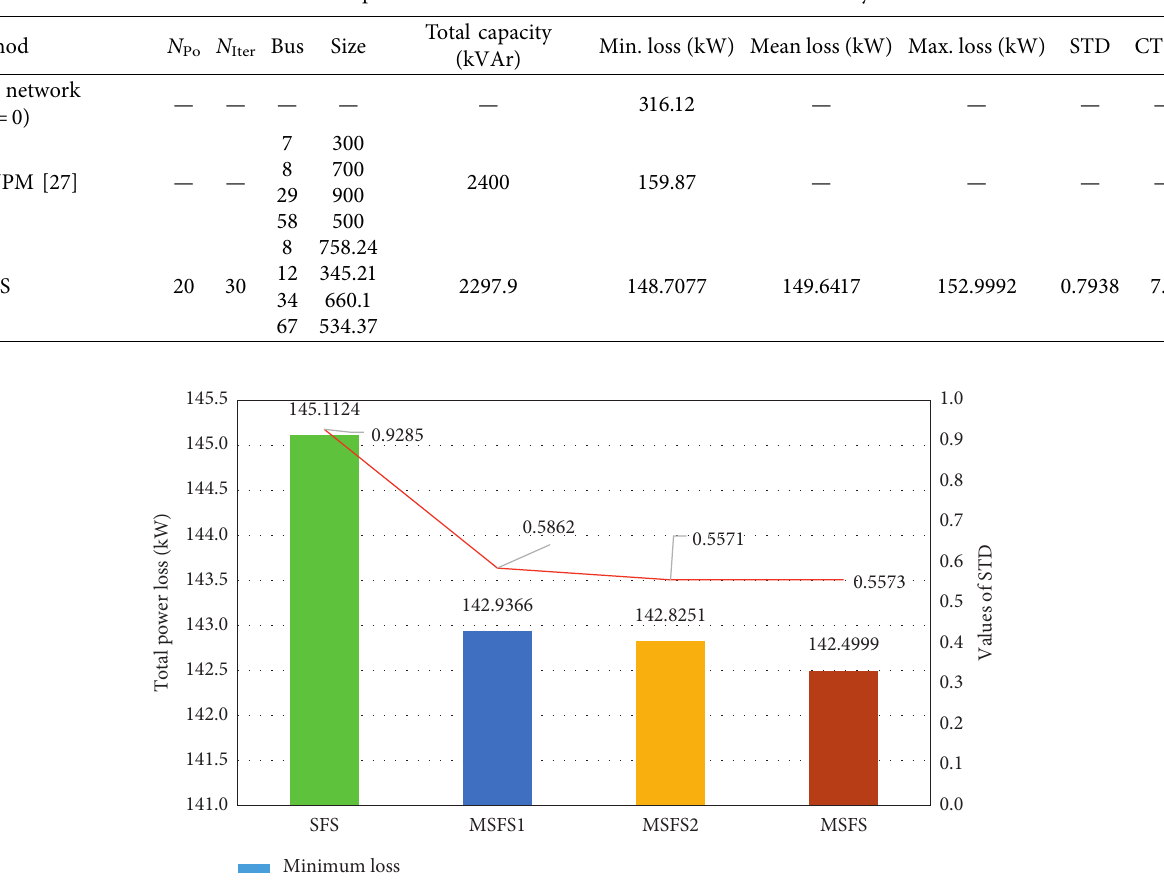
Figure 27: Total power loss of 50 trial runs obtained by SFS methods for case 3 of the 85-bus system. Table 9: Comparison with other methods for case 3 of the 85-bus system.